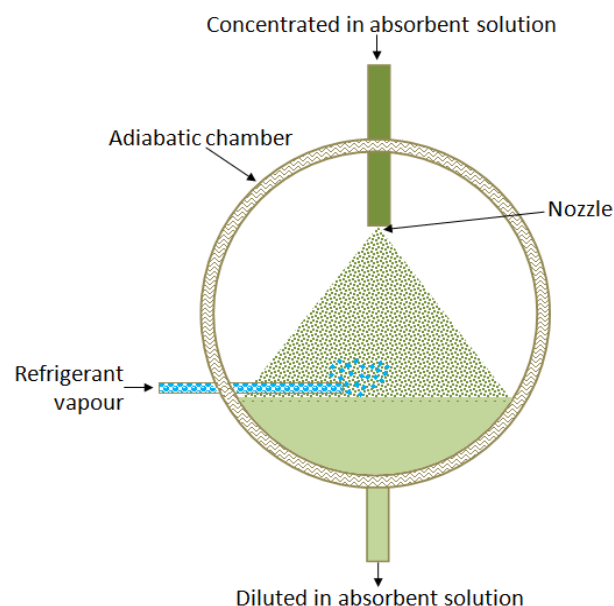
Figure 3. Schematic diagram of an adiabatic absorber